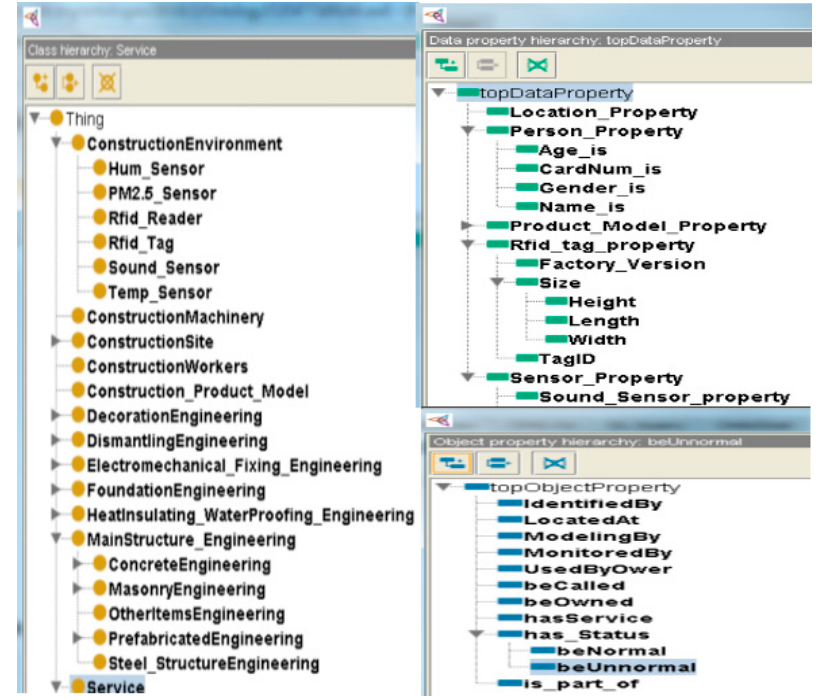
Figure 13. Construction condition ontology.